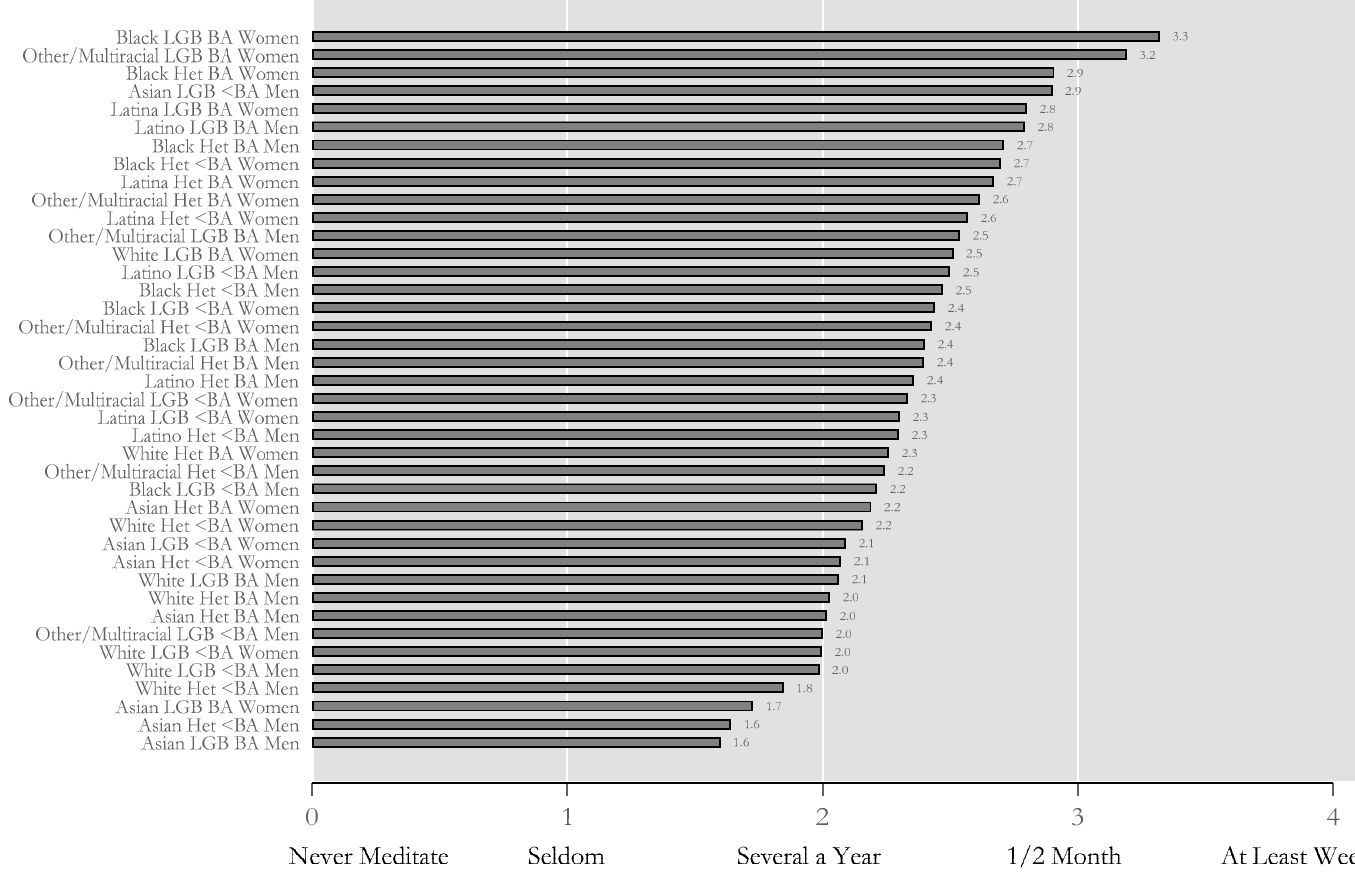
Figure 6. Meditation frequency across configurations of status characteristics, RLS (N = 32,978).